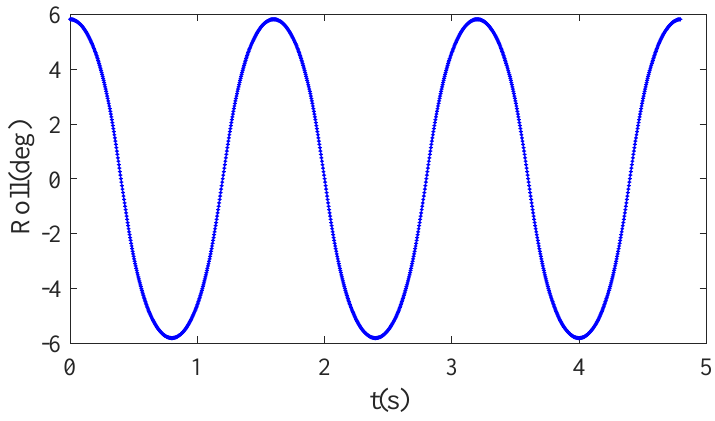
Figure 10. The roll angle curve in crawling